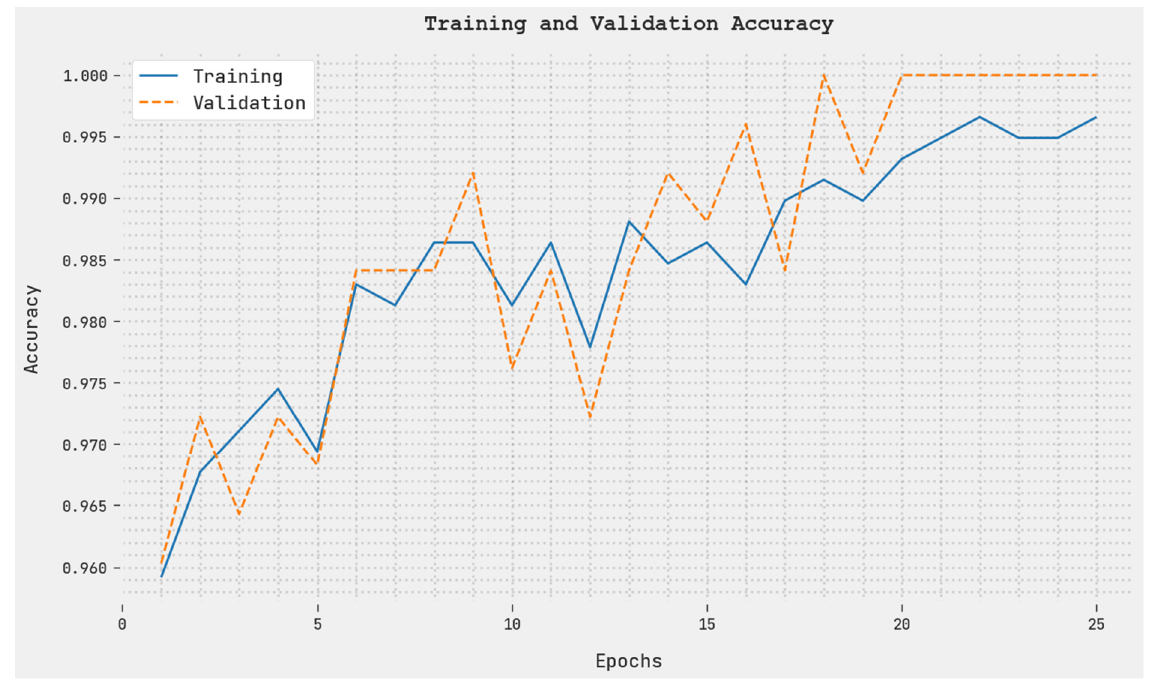
Figure 6. TRA and VLA analysis of DWOML-RWD approach.